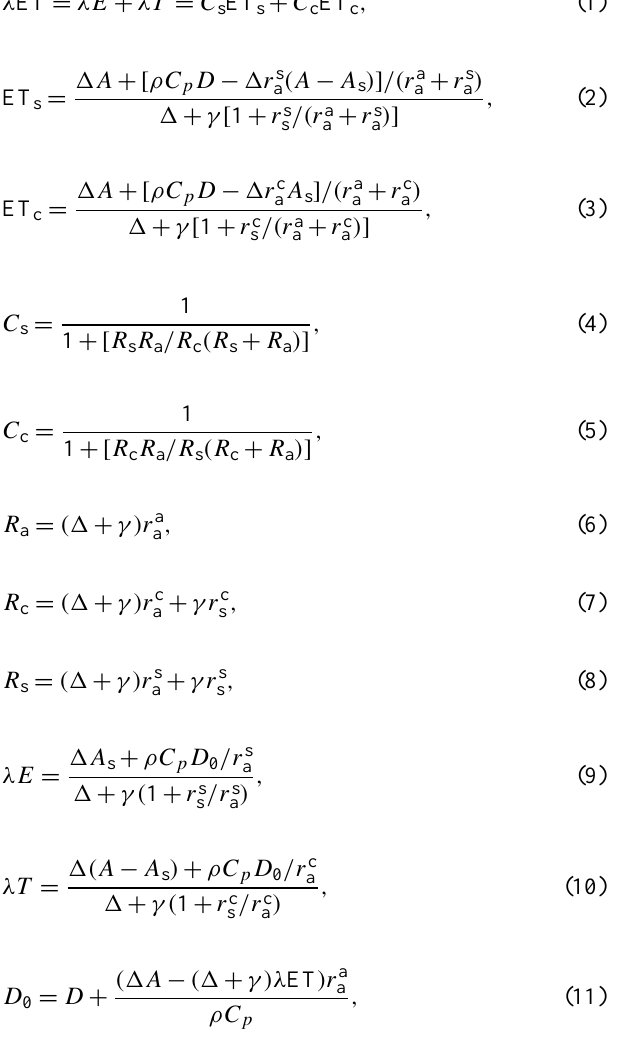
Figure 1. Experimental location and instrumentation setting at the Daman (DM)